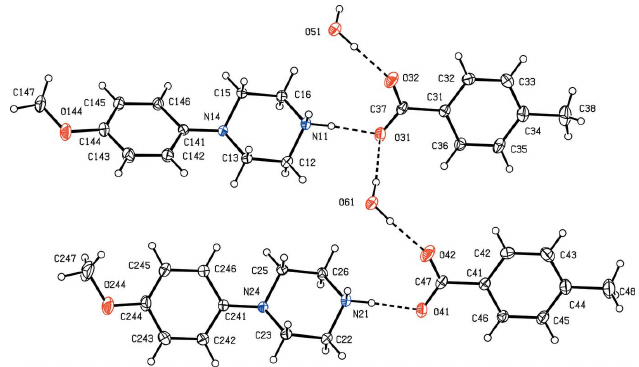
Figure 1 The six independent components in the structure of compound (I), showing the atom-labelling scheme and the hydrogen bonds, drawn as dashed lines, within the selected asymmetric unit. Displacement ellipsoids are drawn at the 30% probability level.